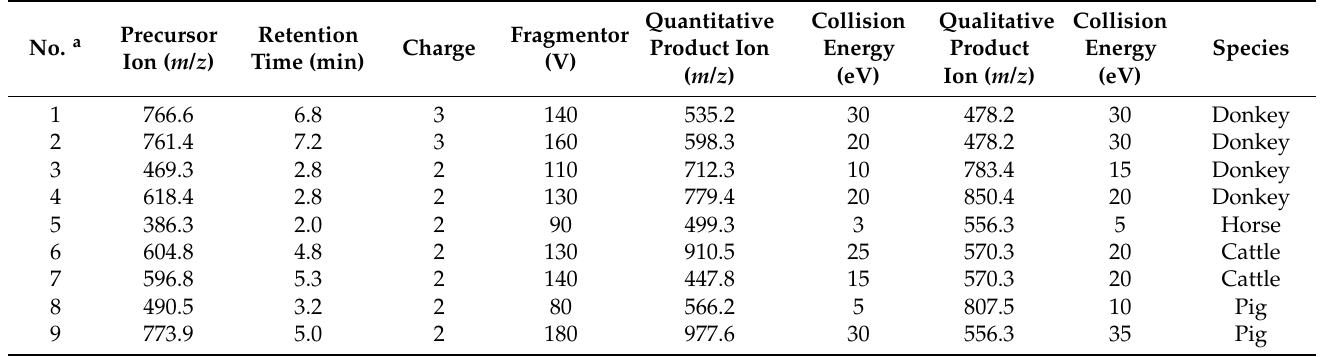
Table 4. The precursor ion, retention time, product ion, and collision energy of the selected species- specific markers.